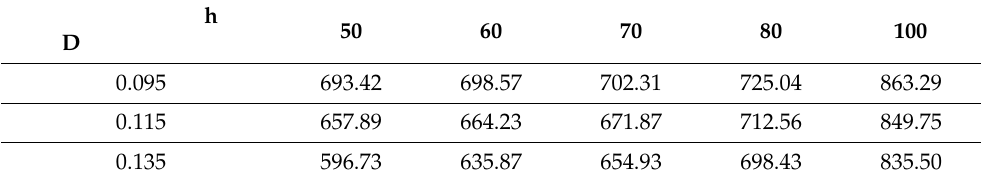
Table 8. The final overall length of the mooring line (unit: m).